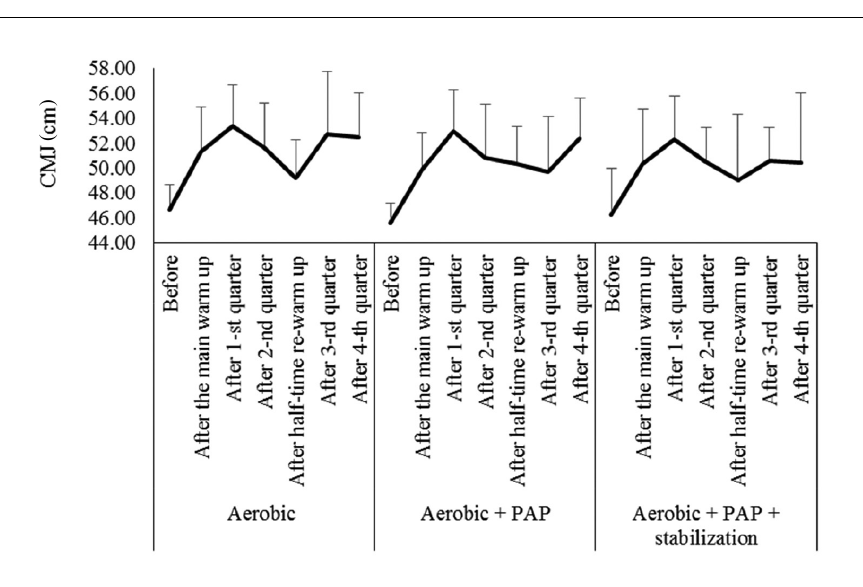
Figure 2. Mean values of vertical jump height during the